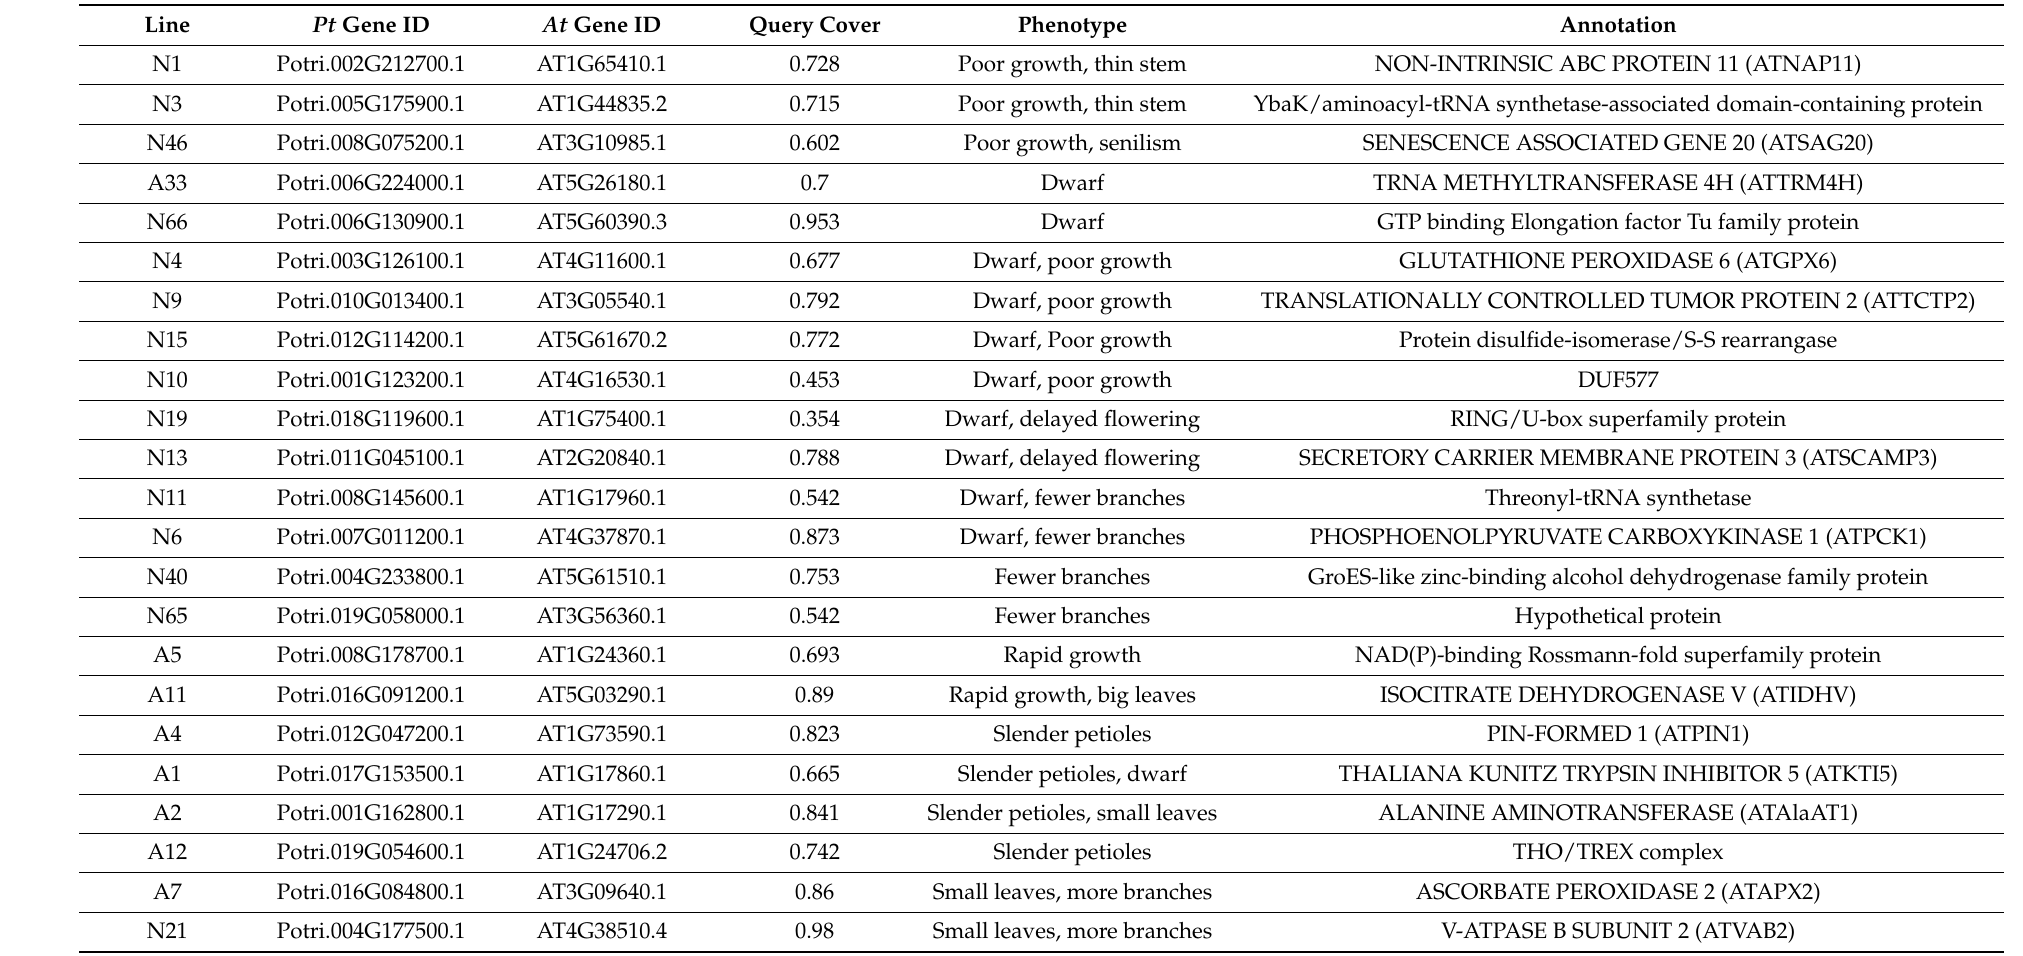
Table 1. Phenotypes and functional annotation of mutant FOX